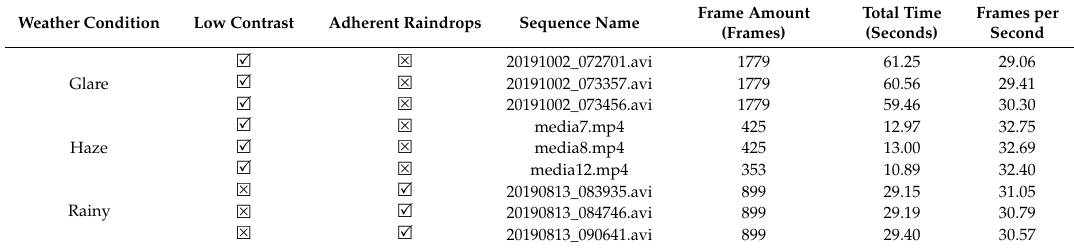
Table 4. Detection performance comparison between the non-corrected image and corrected image.